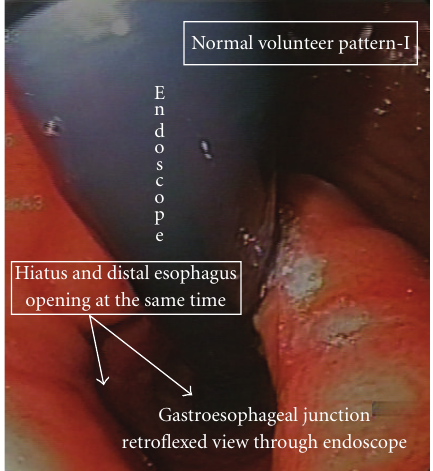
Figure 3: This is pattern I opening. This picture shows a retroflexed view of the gastroesophageal junction in a normal volunteer. Note that the entire distal esophagus is open around the endoscope after air insu ffl ation into the stomach.